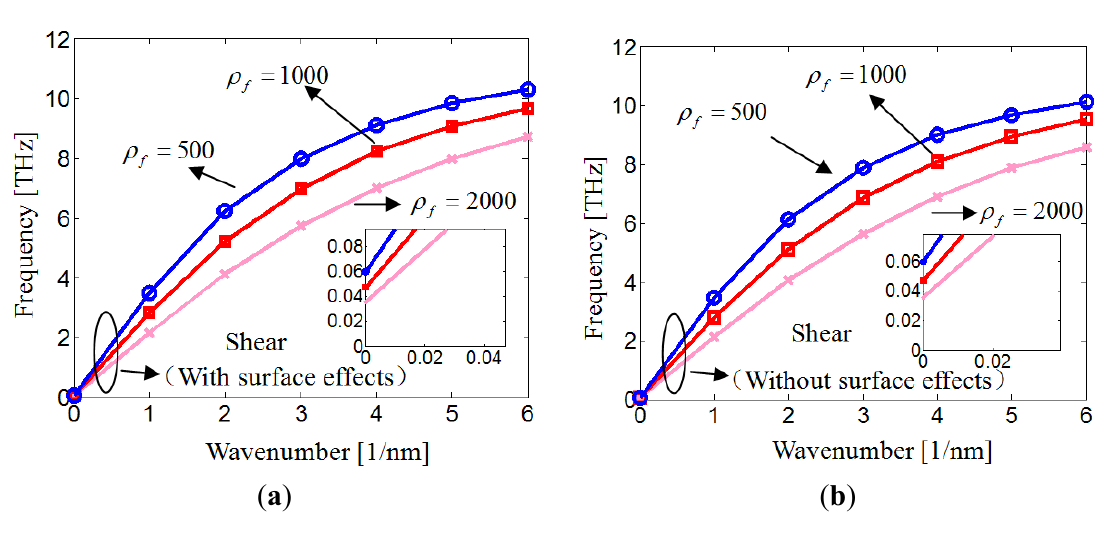
Figure 3. Shear wave dispersion of nanotube conveying fluid with different fluid densities.